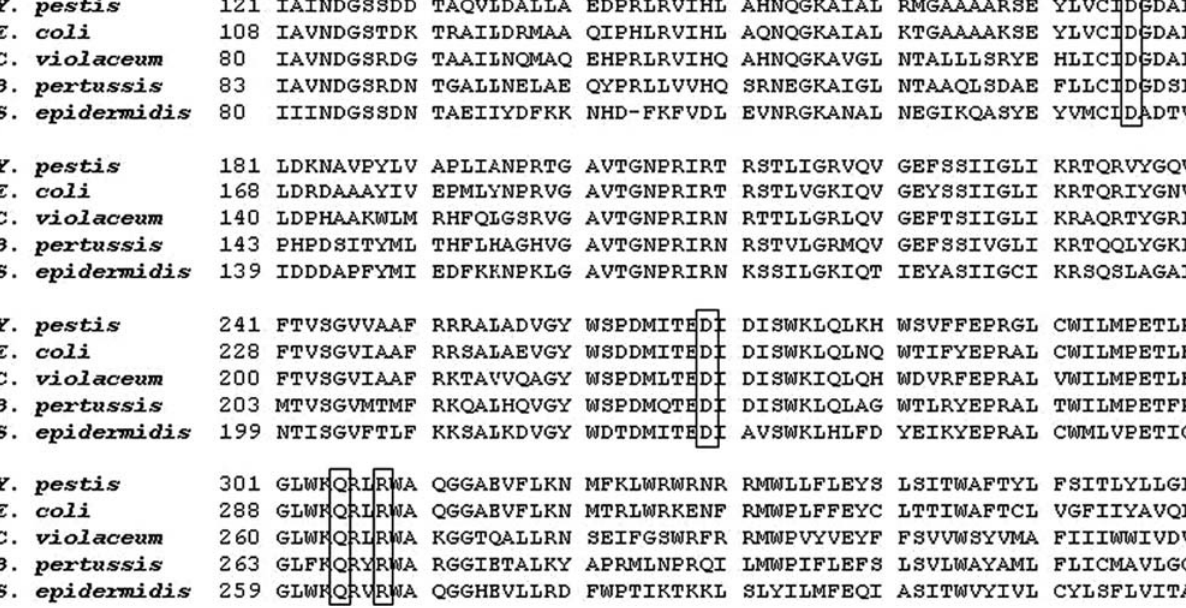
Figure 1 - Partial multiple alignment of HmsR from C. violaceum compared with HmsR of Y. pestis ; PgaC of E. coli ; IcaA of S. epidermidis and HmsR of B. pertussis . The critical residues aspartate (D), glutamine (Q) and arginine (R) are demarcated.